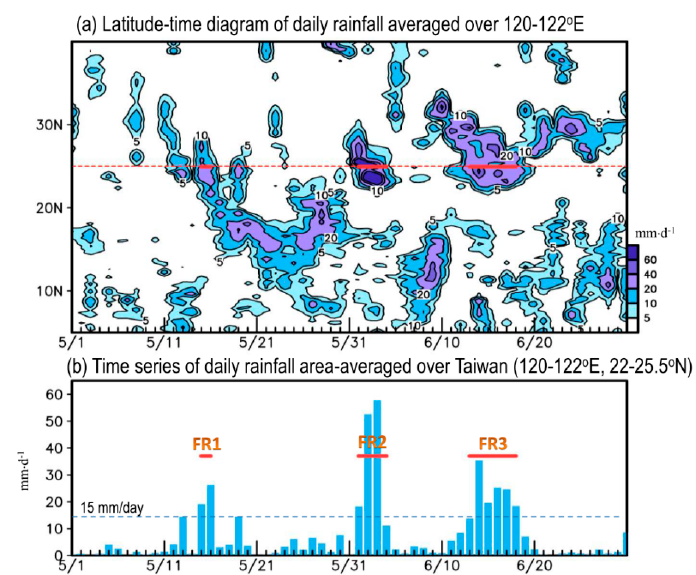
Figure 1. ( a ) Latitude-time diagram of daily rainfall averaged over the longitudinal zone of Taiwan (120–122° E), extracted from the GPM IMERG rainfall production, during May and June 2017. ( b ) The related time series of daily rainfall area averaged over Taiwan (120–122° E, 22–25.5° N). In ( b ), three heavy rainfall events (denoted as FR1~FR3) are defined based on the criterion that the daily rainfall > 15 mm/day continues for at least two days. The dashed orange line in ( a ) indicates the location of Taiwan (around 25° N).